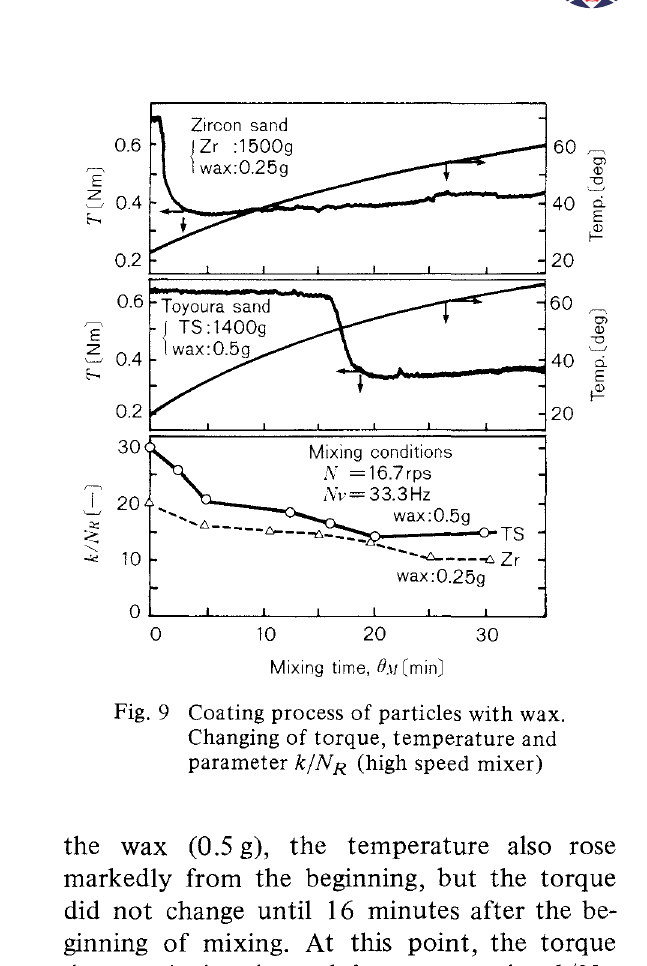
Fig. 9 Coating process of particles with wax. Changing of torque, temperature and parameter k/NR (high speed